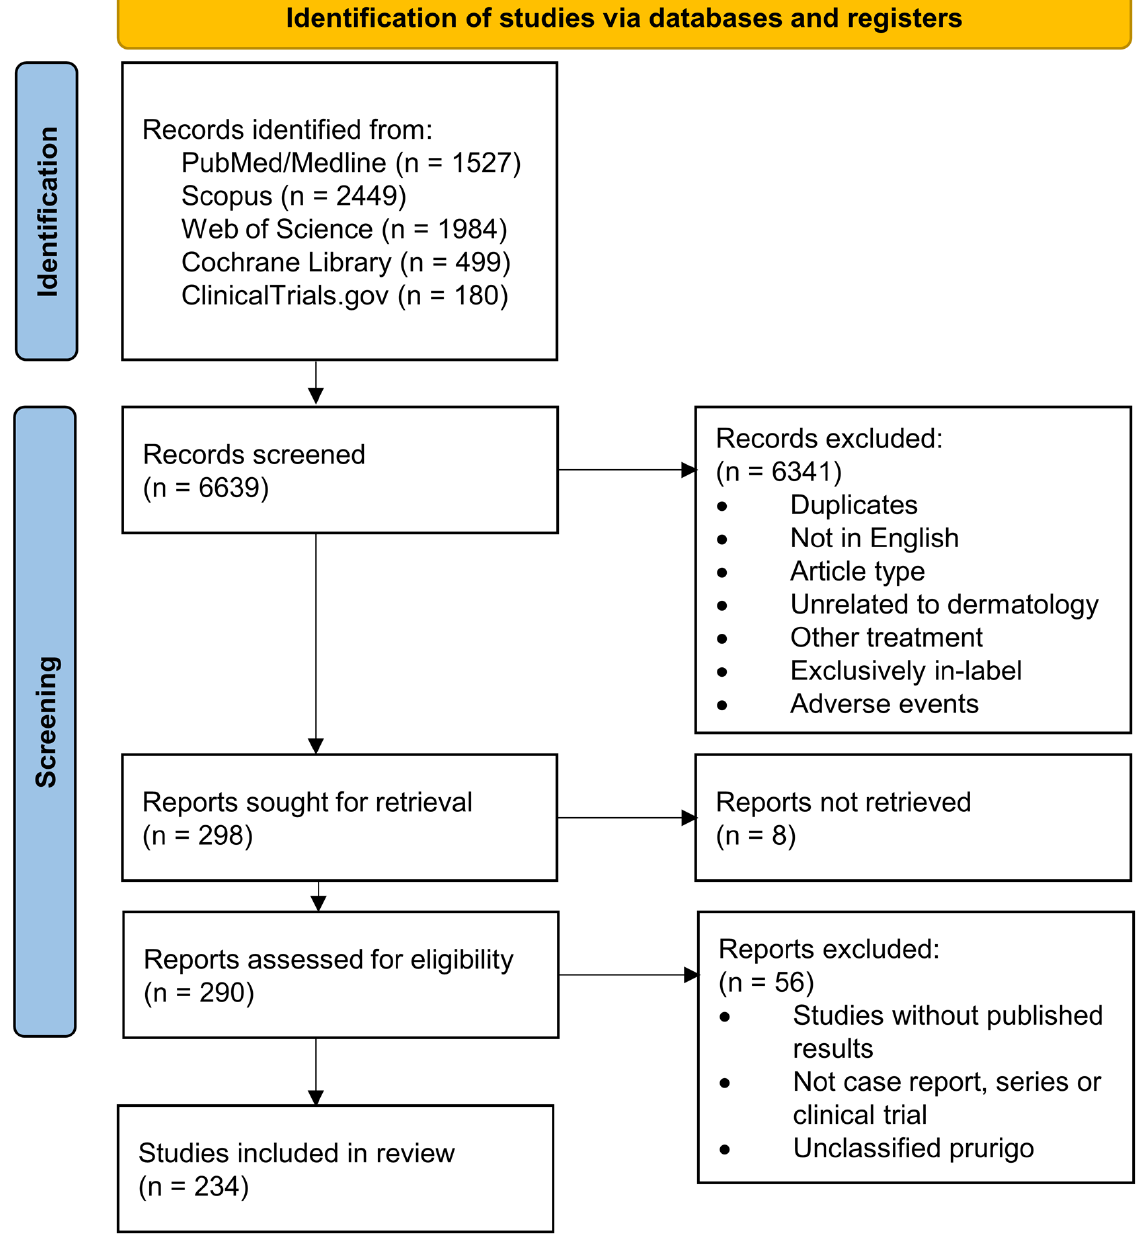
Figure 2. PRISMA flow diagram depicting the different phases of this systematic review.